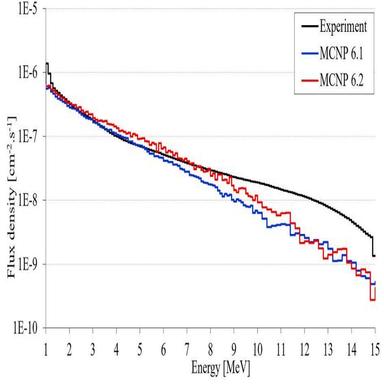
Comparison of calculated and STAYSL evaluated neutron spectra in the center cut in angle 33.69 deg.